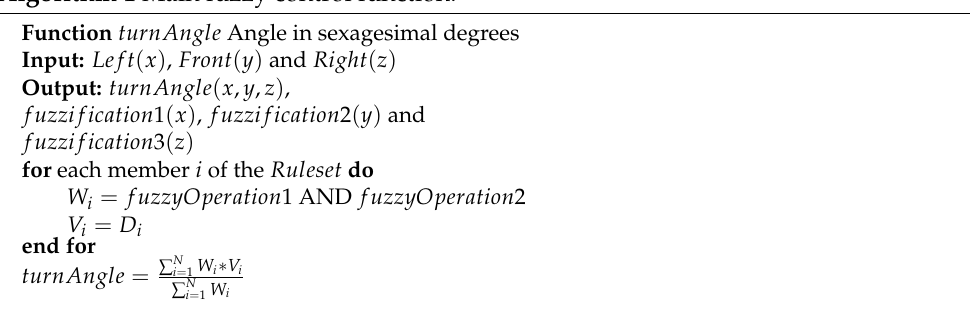
Figure 12. Examples of operation by using Era-Mobi: ( a – d ) path with many obstacles. Part (d) is the inputs of the turnAngle function, which produces an angle for avoiding obstacles. Algorithm 1 presents a pseudo code, where V i are computed from D i , and the rule set is described in Table 1. Algorithm 1 Main fuzzy control